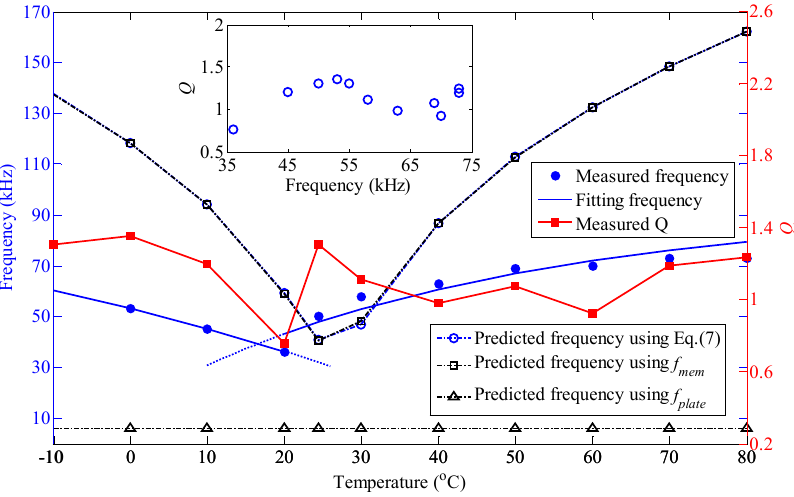
Figure 5. Resonance frequency f and Q factor as a function of temperature. Inset: Q factor verse f .